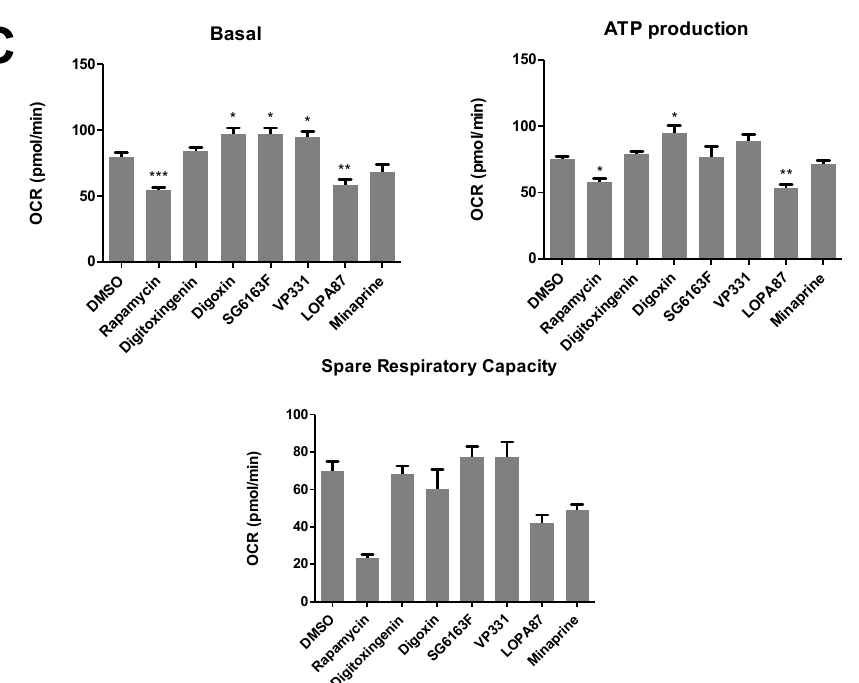
Figure 9. Metabolic reprogramming effects. ( A ) H9c2 cells were treated with indicated compounds for 6 h, and glycolytic function ( A ) and mitochondrial respiration ( B ) were measured by XFe96 Extracellular Flux Analyzer. ( C ) The oxidation of exogenous fatty acids was measured using the XF Palmitate-BSA FAO Substrate kit. OCR rates are expressed for 20,000 cells per well. Experiments were repeated three times. Data are presented as mean ± SEM with one-way ANOVA, Sidak’s multiple comparisons test. *, p < 0.05, **, p < 0.01, ***, p < 0.001 vs. DMSO.